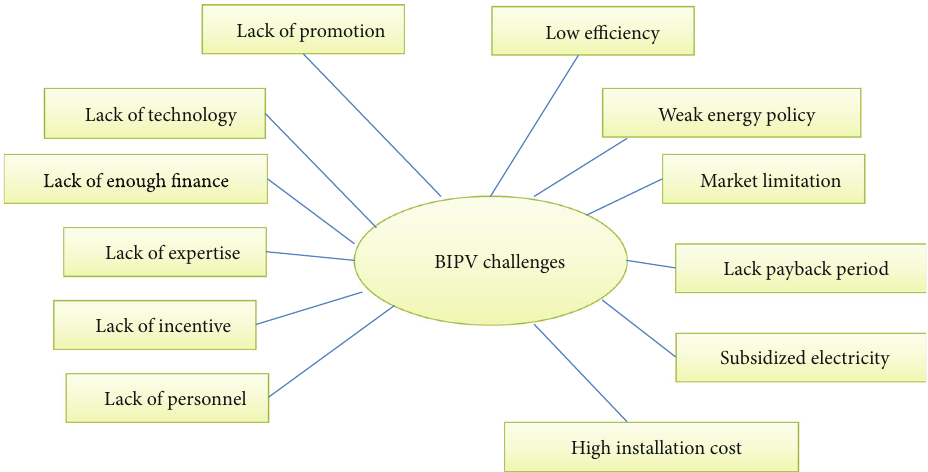
Figure 14: Challenges of the semitransparent BIPV